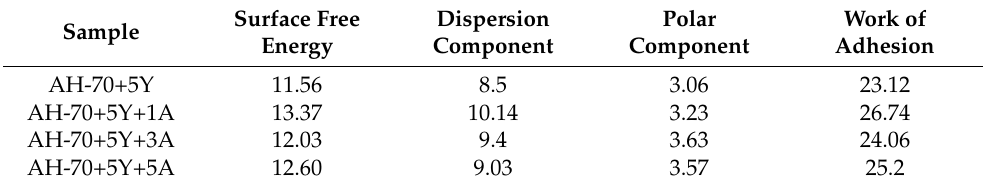
Table 6. A-Pal-compounded SBS-modified asphalt surface energy (mJ/m 2